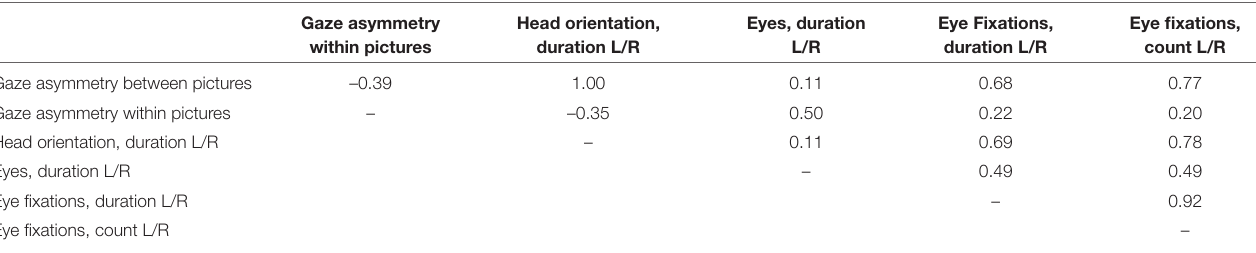
TABLE 4 | Correlations between VR measures, calculated using a pearson correlation